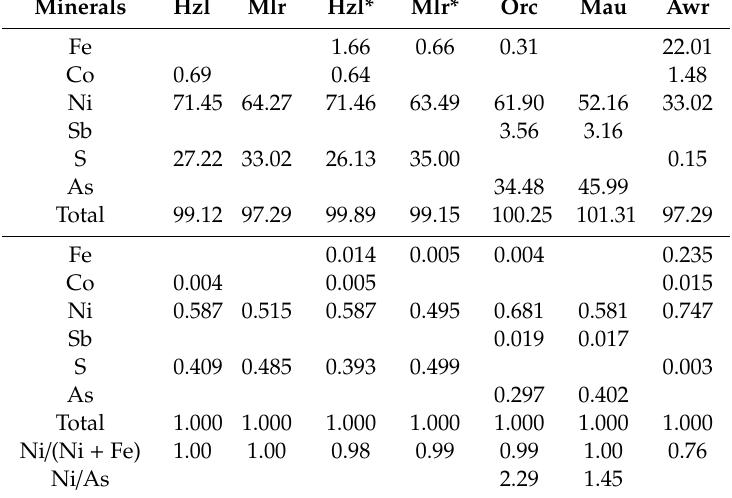
Table 2. Selected SEM analyses of sulfides, arsenides and alloy in the meta-dunite (T4-8) from Fujiwara in the Sanbagawa metamorphic belt, southwest